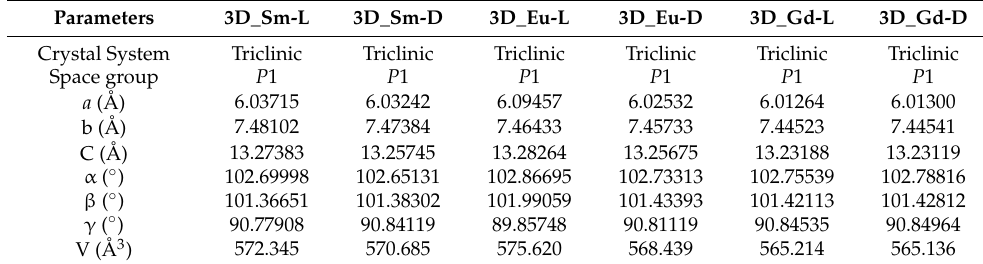
Table 1. Crystallographic data of 3D compounds.